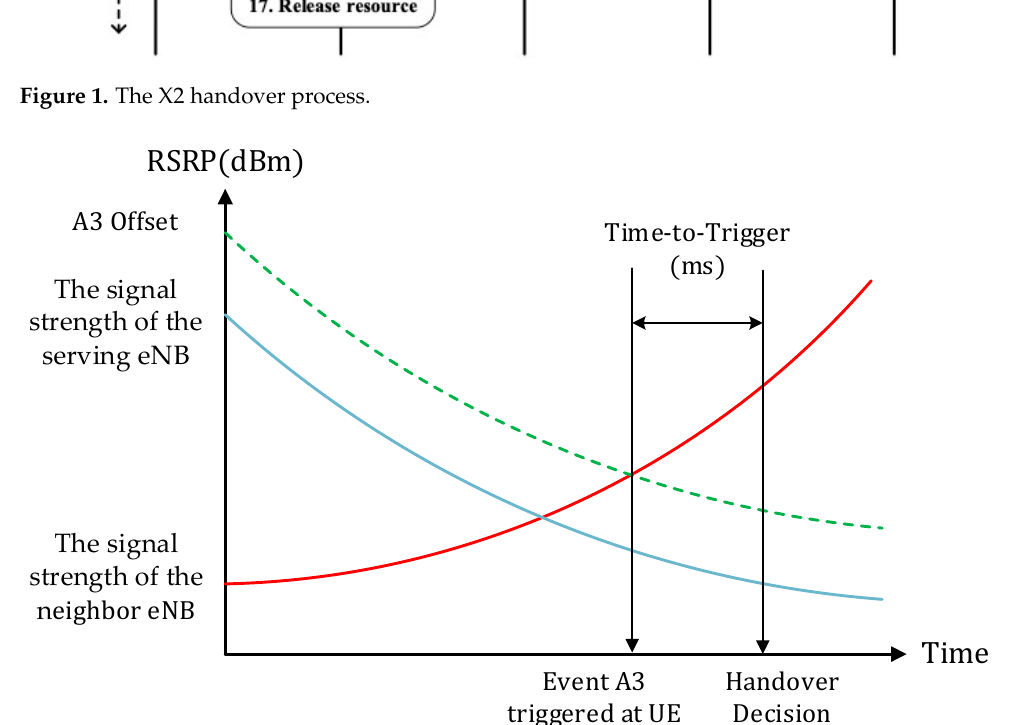
Figure 1. The X2 handover process.